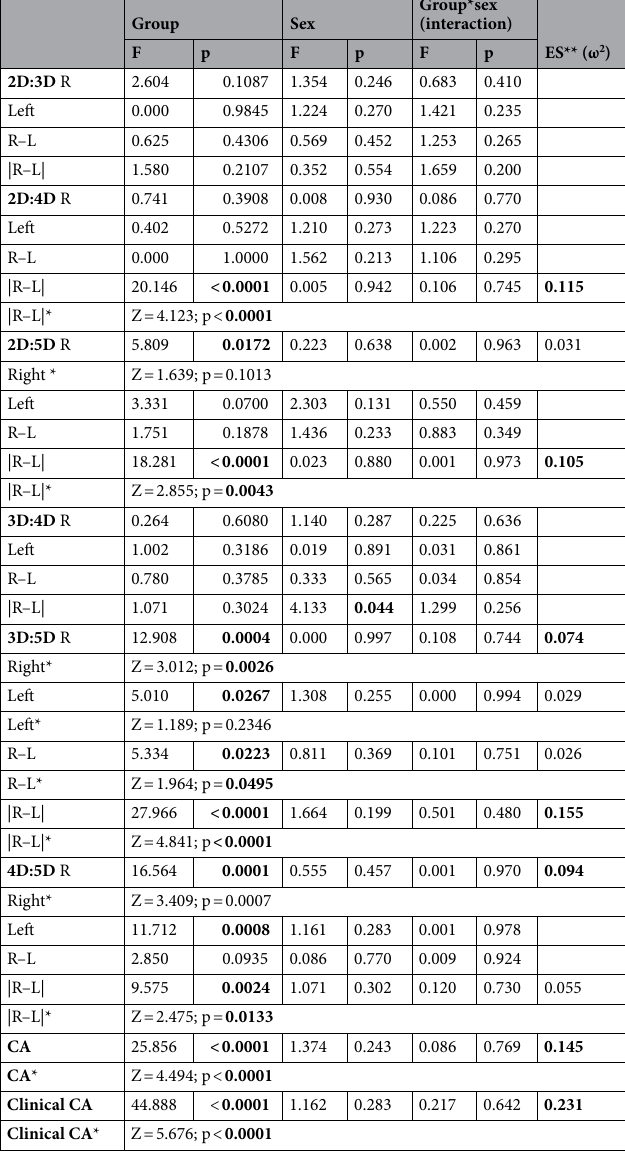
Table 4. Differences in digit ratios and their asymmetries between patients and controls—(ANOVA) controlled for sex. *non-parametric test (Mann–Whitney), ** effect size—ω 2 , CA—Composite